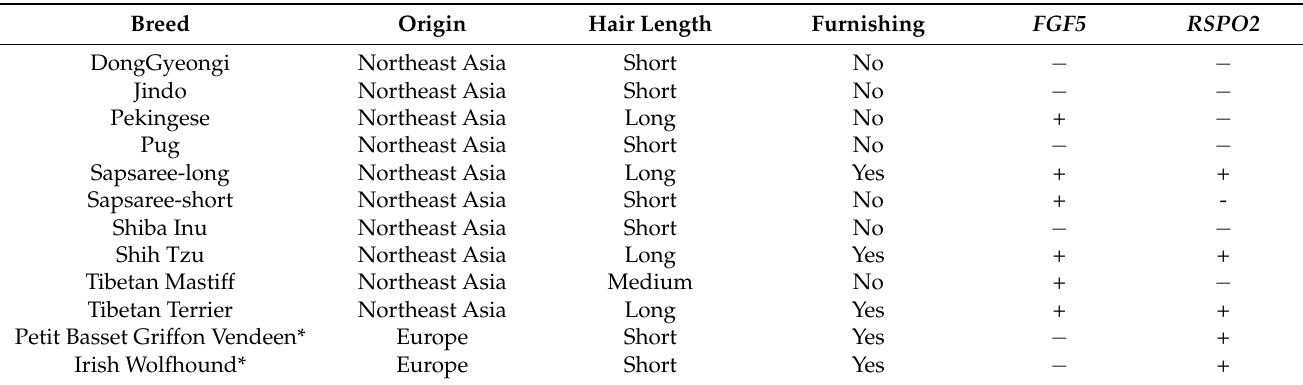
Table 1. Hair length phenotypes and the presence of FGF5 and RSPO2 variants in Northeast Asian breeds and two selected European breeds.